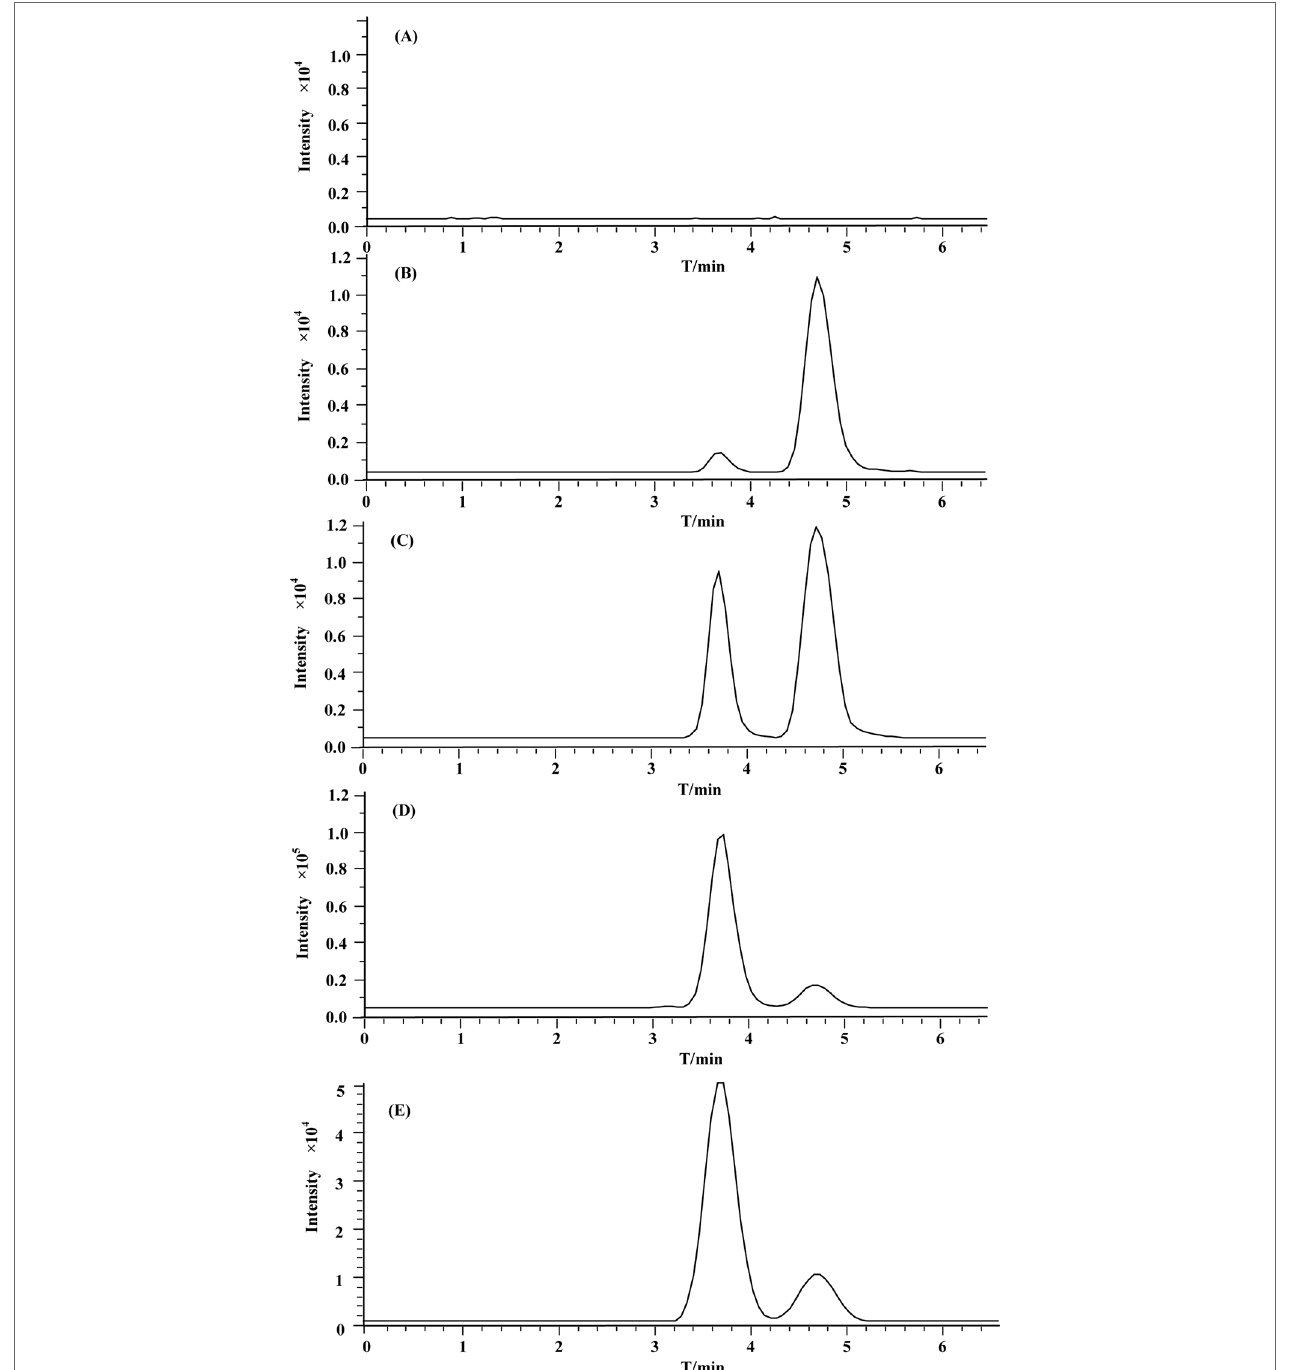
FIGURE 6 | Representative MRM chromatograms of (A) blank rat plasma; (B–D ) (QC samples (30 ng/mL (LQC), 500 ng/mL (MQC), and 5,000 ng/mL (HQC), respectively); (E) rat plasma sample at 45 min after 200 mg/kg oral administration of mogroside